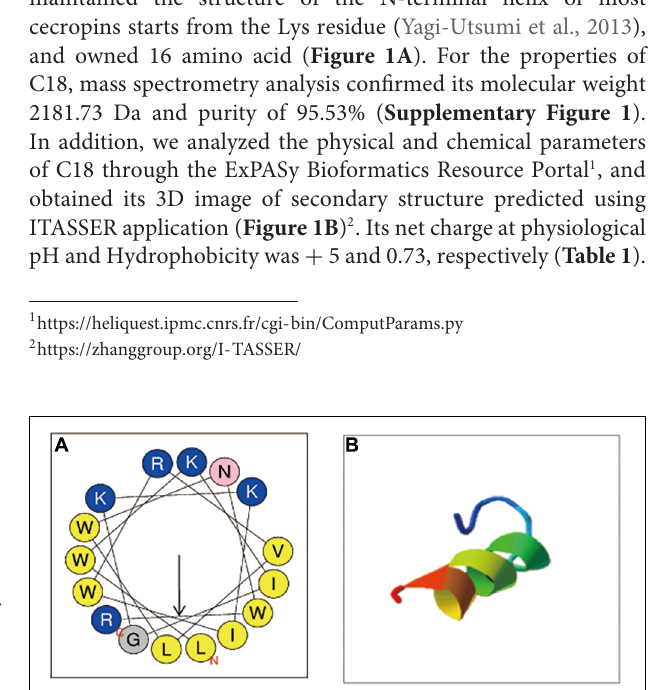
FIGURE 1 | Physicochemical properties of C18. (A) The helical wheels of C18. The helical wheels were constructed with